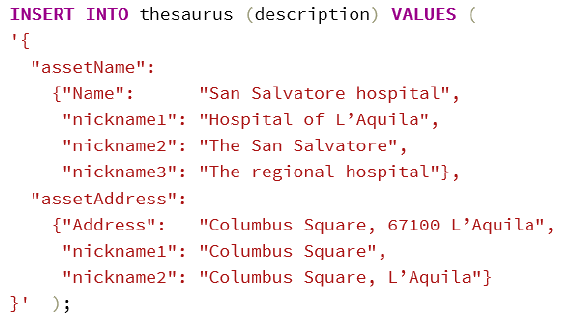
Figure 8. The (JSON) record about the hospital of